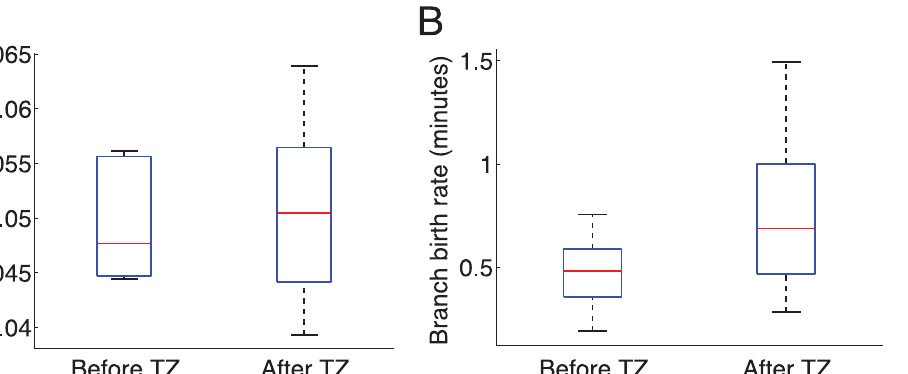
Fig 4. The birth rate of new branches increased after the axon reached the termination zone (TZ). The fitted exponential parameters of branches that appeared before or after the TZ was reached were compared for ten axons. (A): There was no difference detected in the estimated death rate, ^ m , of branches before or after the TZ was reached (p = 0.52, paired t-test). (B): There was a difference in the birth rate, ^ l , of branches before and after the TZ was reached (p = 0.004, paired